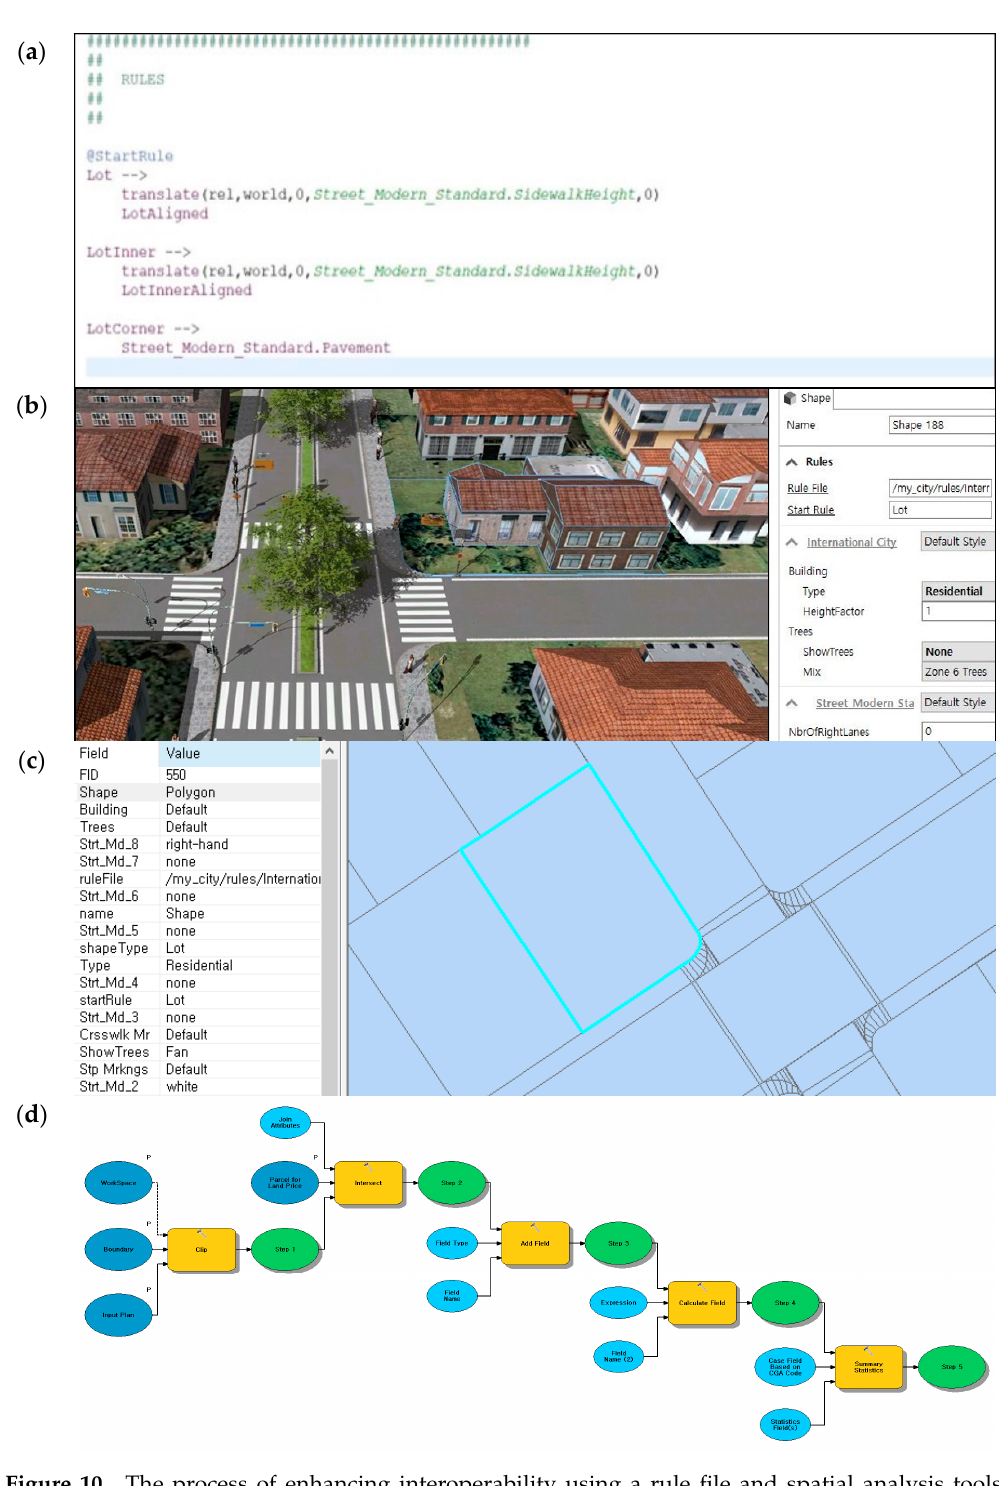
Figure 10. The process of enhancing interoperability using a rule file and spatial analysis tools: ( a ) prepare a variable in the rule file in CityEngine; ( b ) generate a model using the rule file; ( c ) Export the model to ArcGIS; and ( d ) Analyze the cost using a spatial analysis tools in ModelBuilder customized for the variable.